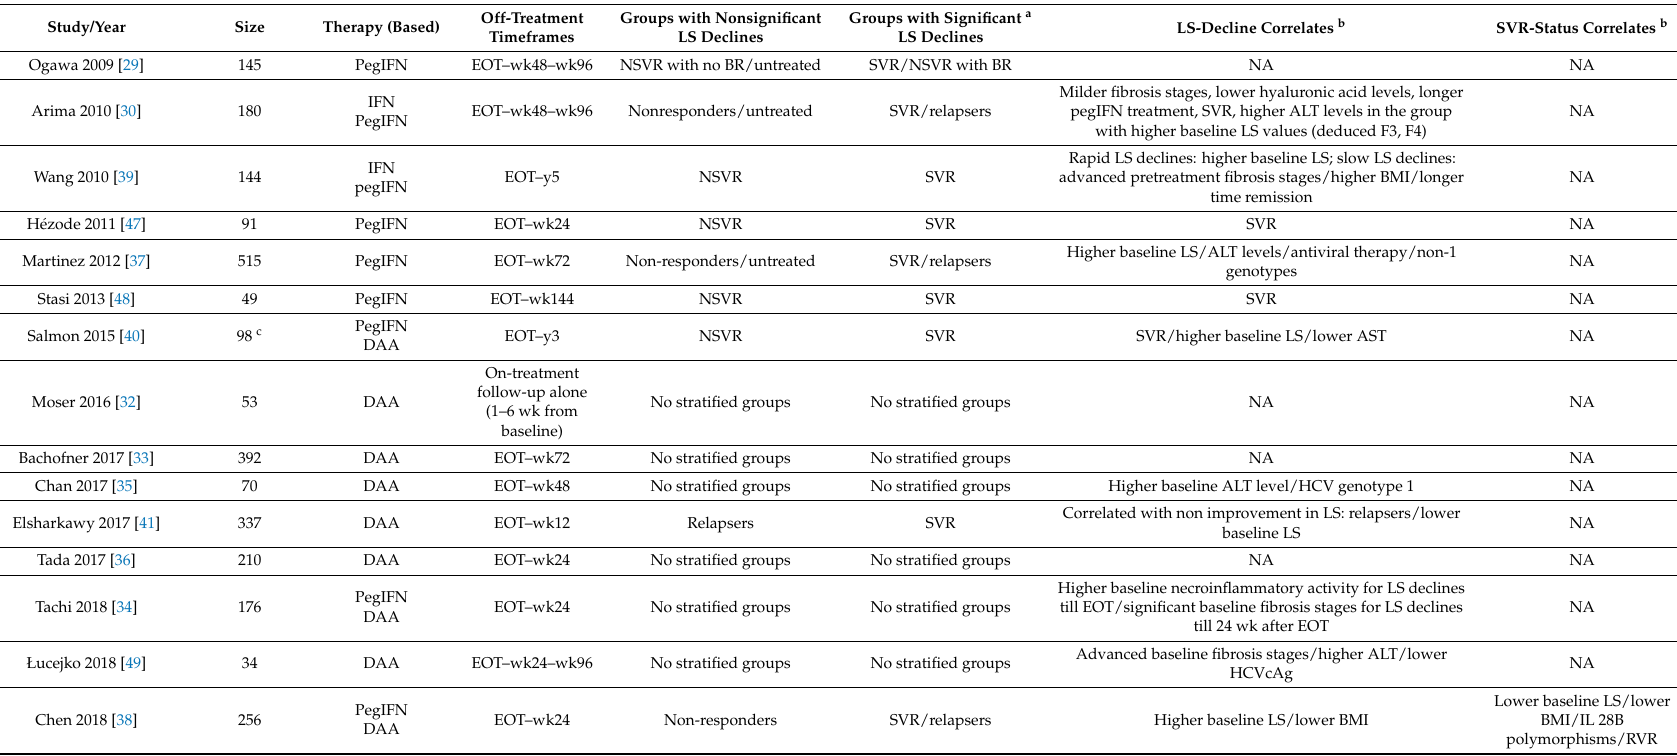
Table 1. Published studies on liver stiffness surveillance in patients with chronic hepatitis